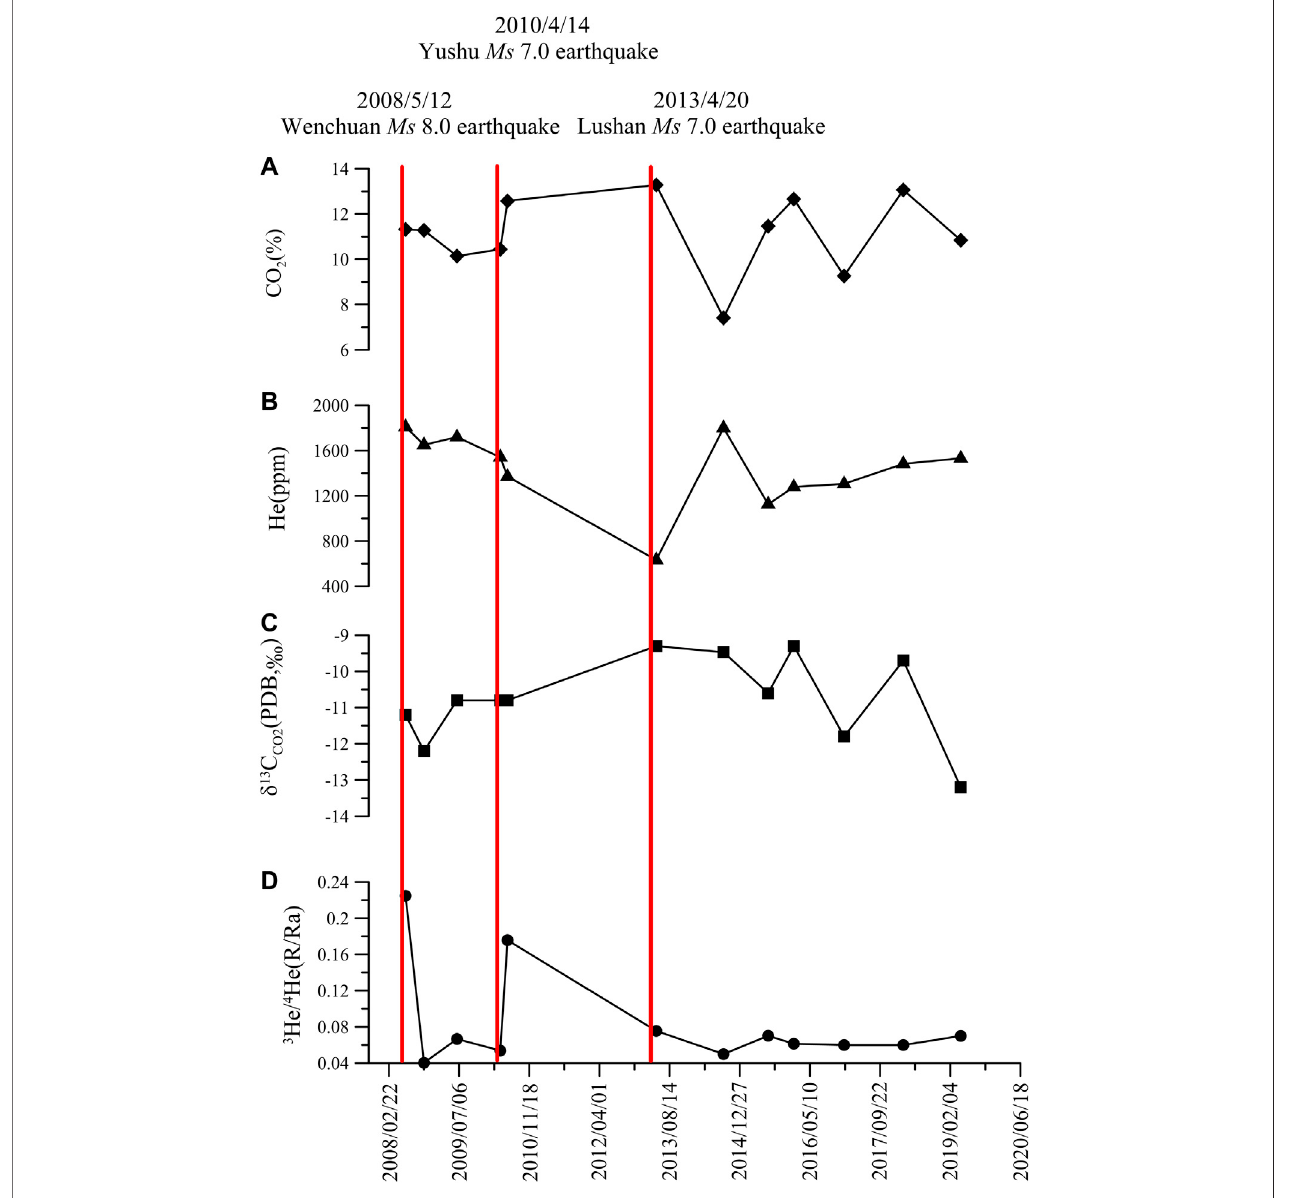
FIGURE7| TemporalvariationsofCO 2 concentration (A) ,Heconcentration (B) , δ 13 C CO2 ( ‰ ,PDB)values (C) , 3 He/ 4 He(R/Ra) (D) valuesinthespringgassamples.